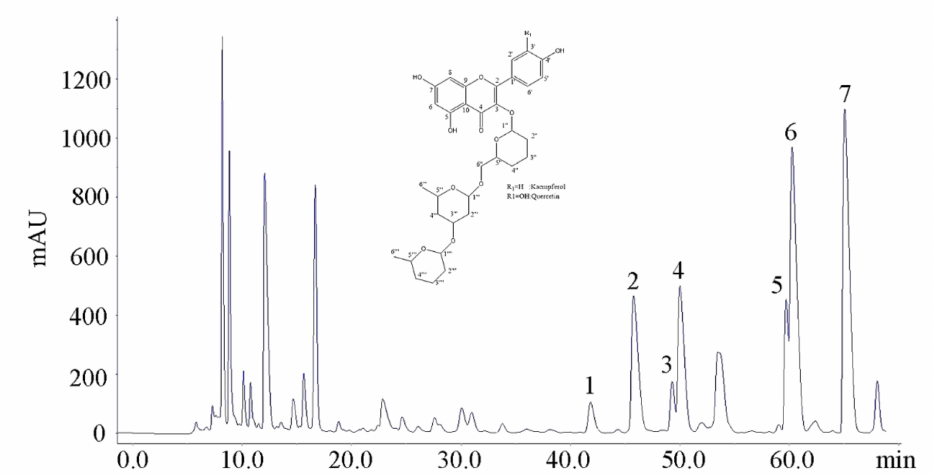
Figure 3. The preparative HPLC chromatogram of 45% methanol fraction. Peaks 1: Q-gal-rha-glu; Peak 2: Q-glu-rha-glu; Peak 3: Q-gal-rha-rha; Peak 4: Q-glu-rha-rha; Peak 5: K-gal-rha-rha; Peak 6: K-glu-rha-glu; Peak 7: K-glu-rha-rha based on the results of UPLC–DAD–MS / MS analysis. Inset: